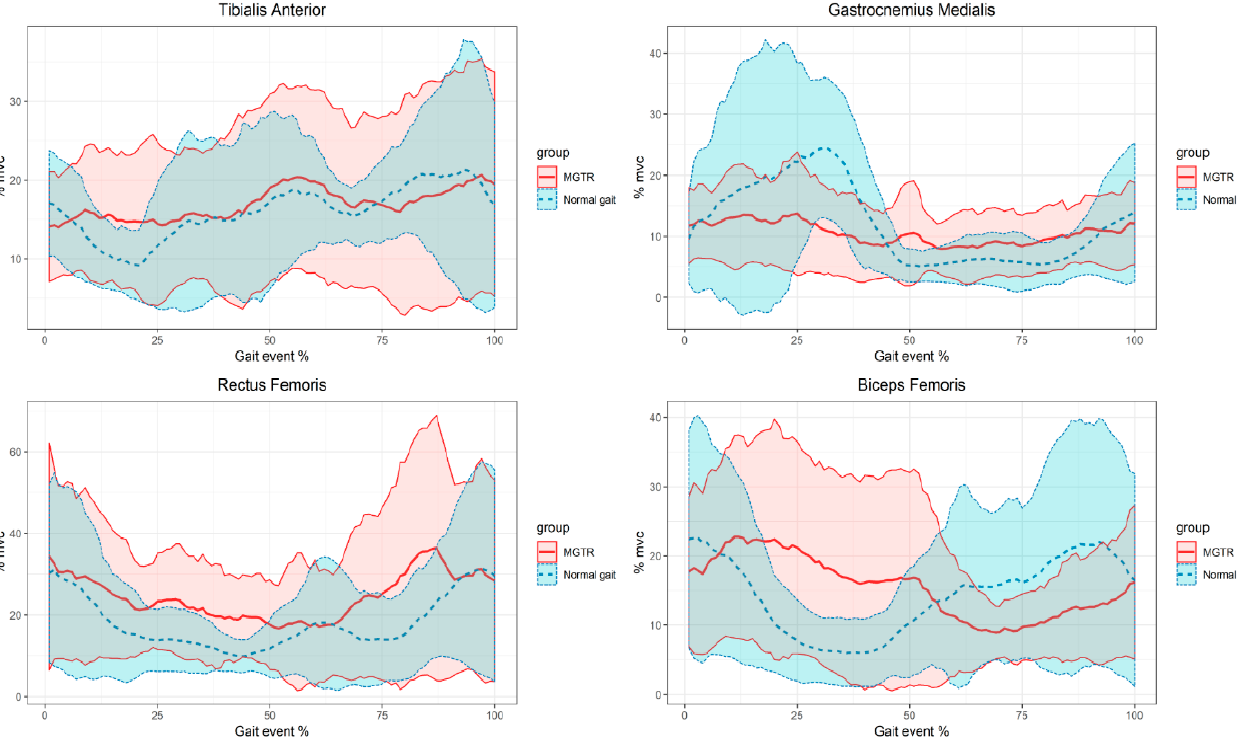
(Mean: bold lines, Standard deviation: both sides of bold lines) Figure 5. Results of the muscle activities with the gait cycle. Figure 5. Results of the muscle activities with the gait